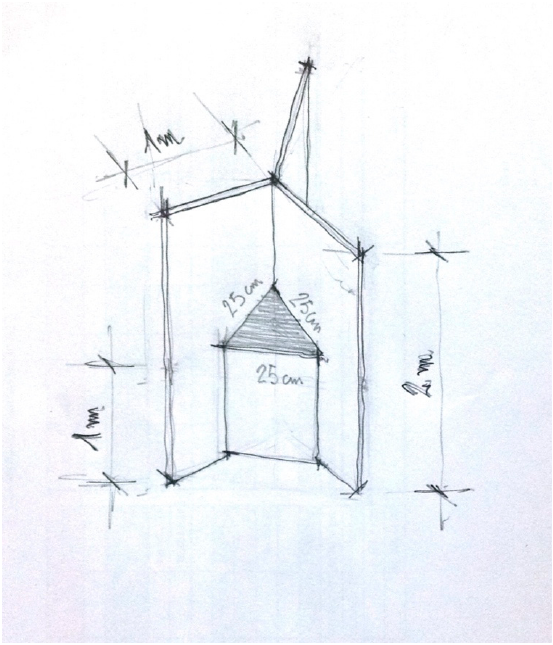
Figure 4. Sketch of Communications Game version 2 (c. 1972). © Ernest Edmonds.